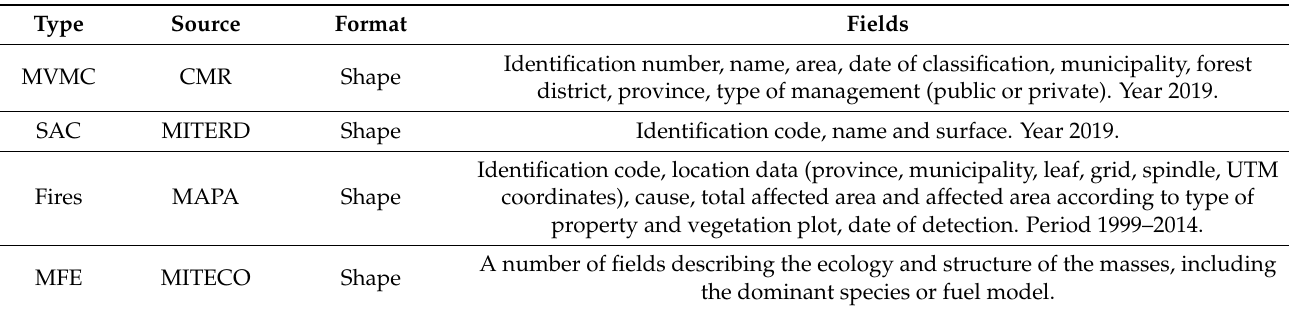
Table 1. Official databases used in the